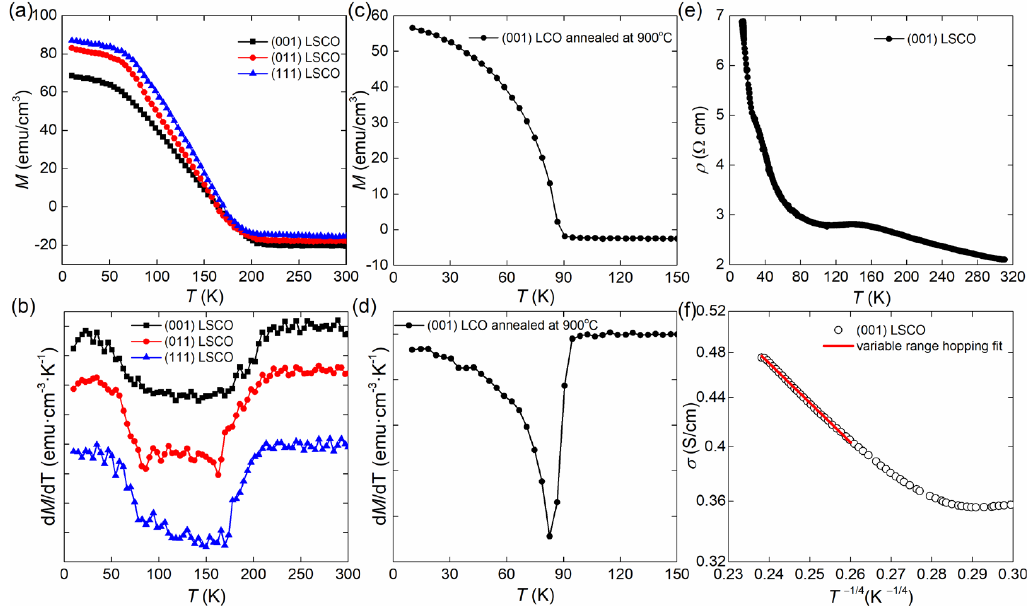
Figure 7. (Color online) ( a ) Temperature dependence of the LSCO magnetization ( M vs. T ) with an external magnetic field H = 100 Oe parallel to the film surface; ( b ) Temperature dependence of the differential magnetization of the LSCO. The curves are shifted, in turn, for clarity. ( c ) Temperature dependence of the LCO magnetization. ( d ) Temperature dependence of the differential magnetiza- tion of the LCO. ( e ) Temperature-dependent resistivity of the (001)-orientated LSCO film. ( f ) Tem- perature-dependent conductivity of the (001)-orientated LSCO film. The vertical coordinate is in the log scale.